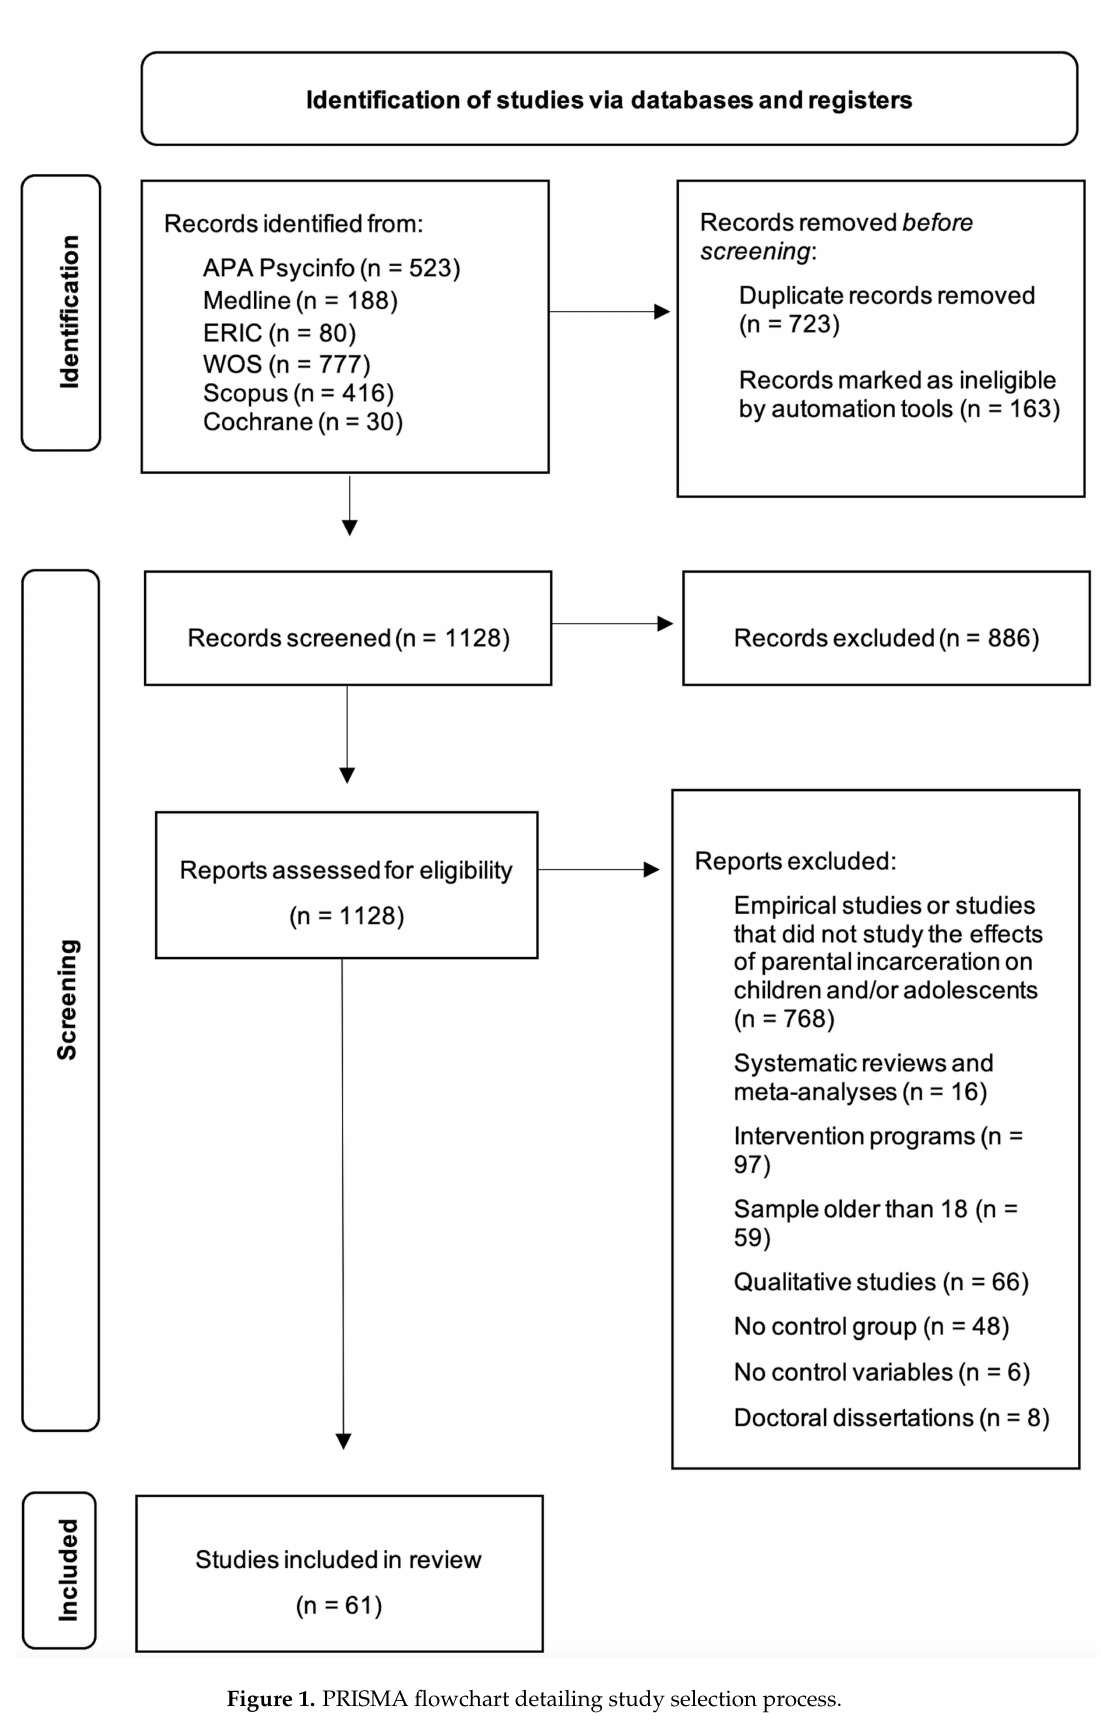
Figure 1. PRISMA flowchart detailing study selection